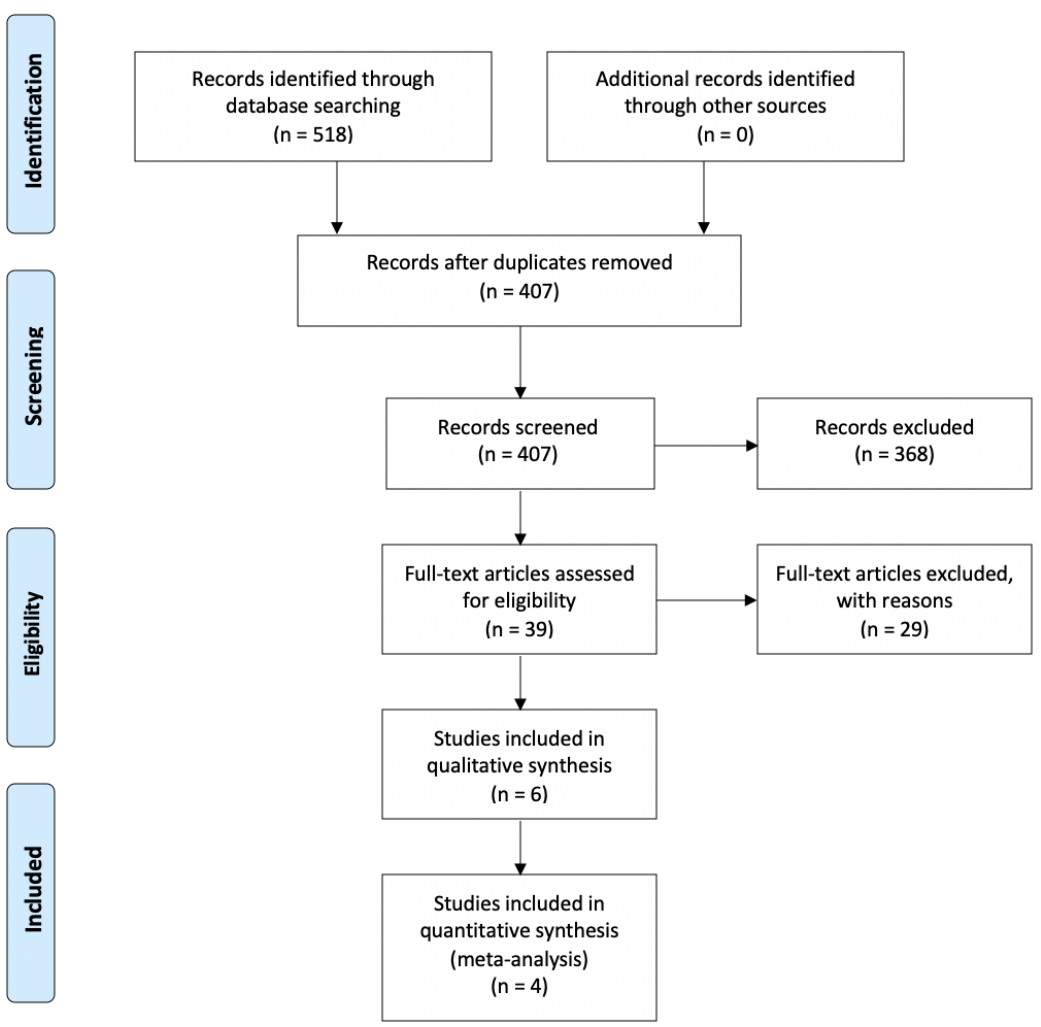
Figure 1. Preferred reporting of systematic reviews and meta-analyses (PRISMA) flow diagram related to bibliographic searching and study selection.